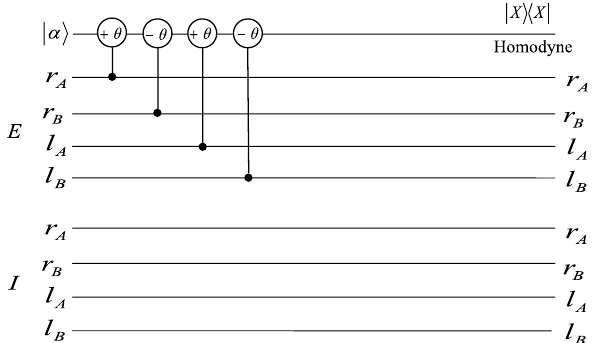
II EE IE EI and from and | � | � | � | �